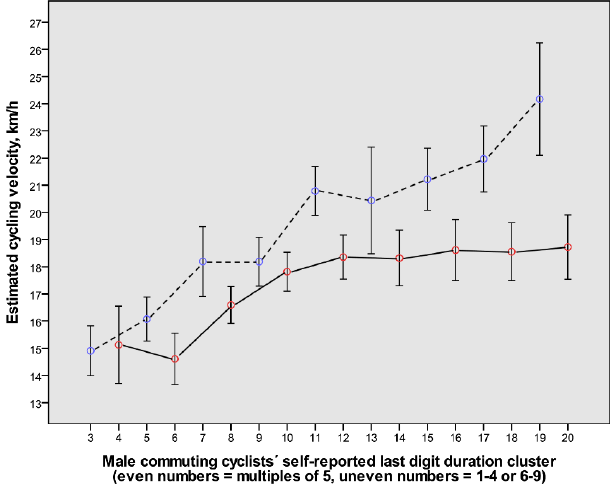
Figure 5. The relation between consecutive clusters of self-reported cycling durations and the estimated cycling velocities for males (mean value and 80% confidence interval) ( n = 498). The even-numbered clusters represent durations with the last digits being 0 or 5 (red symbols connected with continuous lines). The uneven-numbered clusters represent durations with the last digits being 1–4 or 6–9 (blue symbols connected with dashed lines). For further explanations, see legend to Figure 4 and Methods.